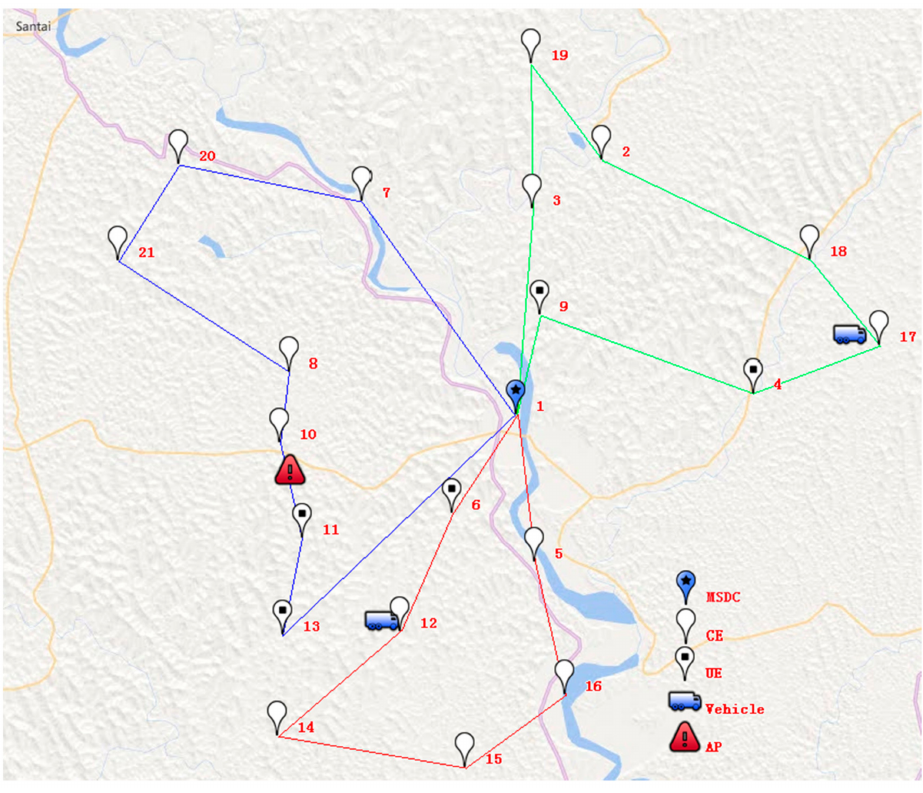
Figure 5. The state when the disturbance occurs.